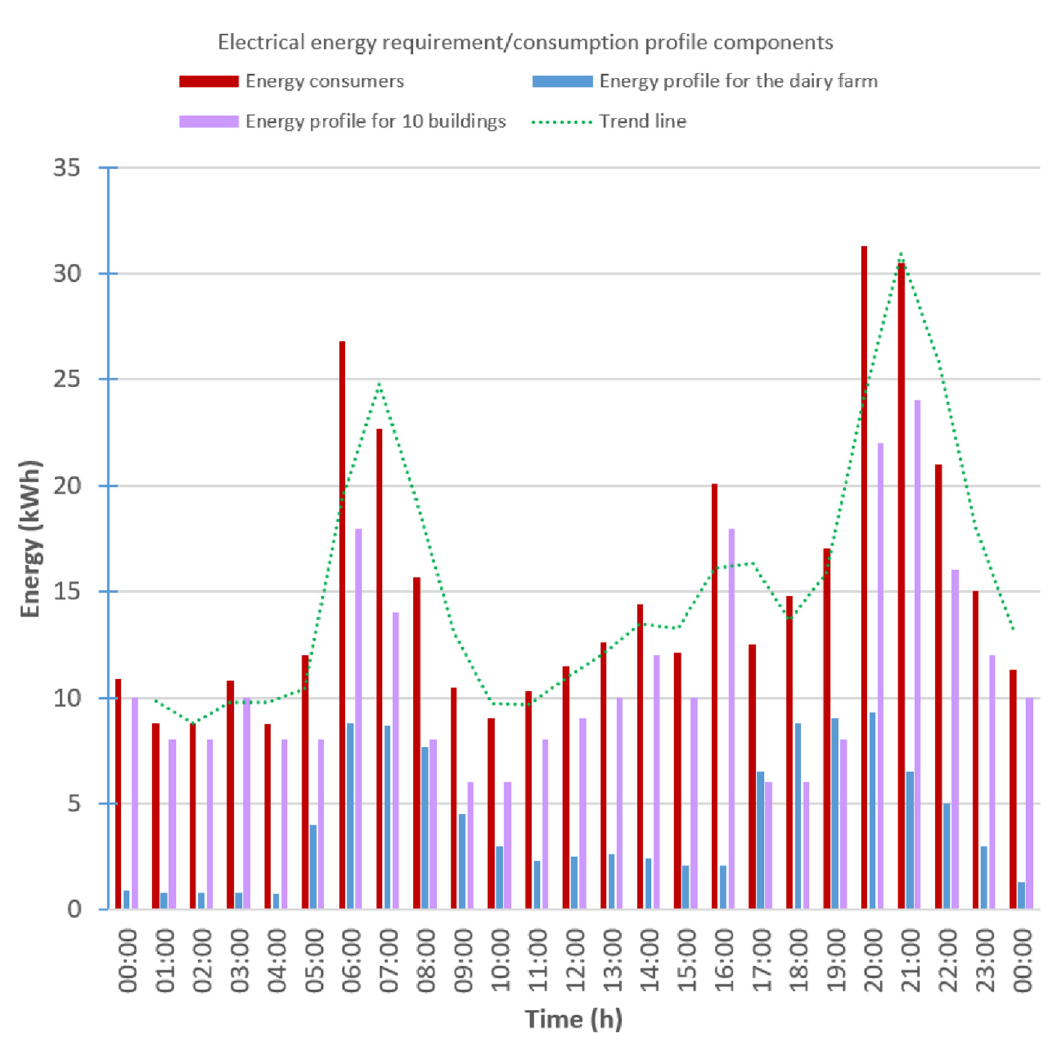
Figure 11. Electrical energy requirement/consumption profile components for farmland and individual recipients and a summary of the energy usage for the analysed energy flow circuit. Own study based on source [55].